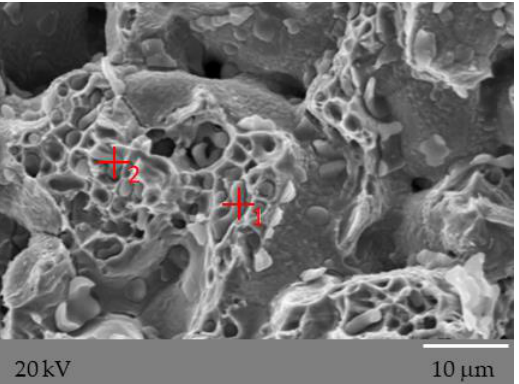
Figure 14. The oxides observed at breakthrough from three-point bending of a sinter made of AISI 316L austenitic stainless steel powder with 0.3 wt% graphite nanopowder with a BET specific surface area of 400 m 2 /g.